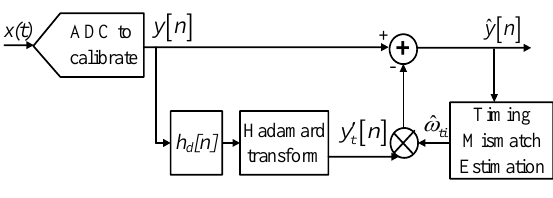
Figure 4. The calibration diagram for the timing mismatch in